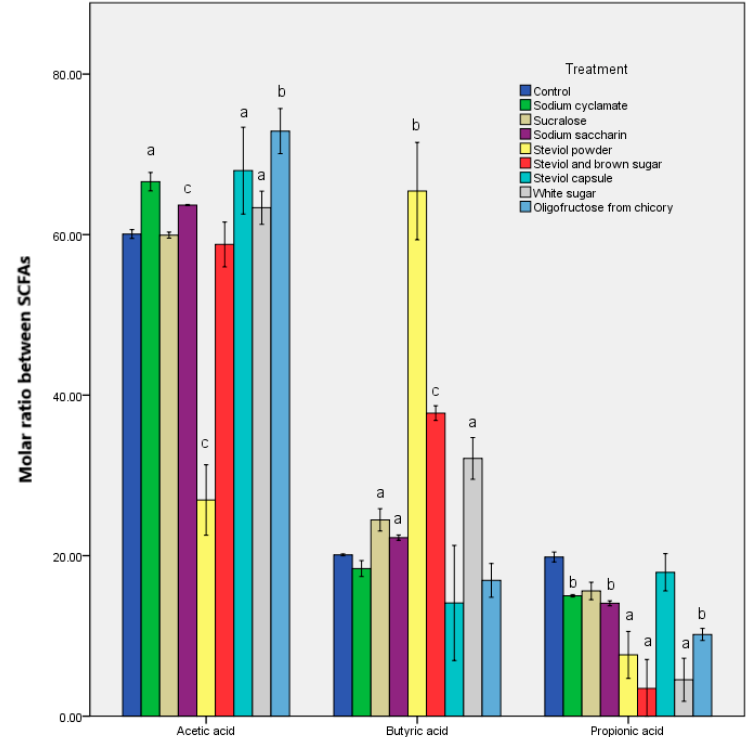
Figure 2. Molar ratio between the acetic, propionic, and butyric acids obtained after the in vitro tests through GIS1 as a measure of the impact of the sweeteners consumed on the metabolic activity of the microbiota. Different letters indicate significant statistical differences (a: p ≤ 0.05; b: p ≤ 0.01; c: p ≤ 0.001), n = 3.